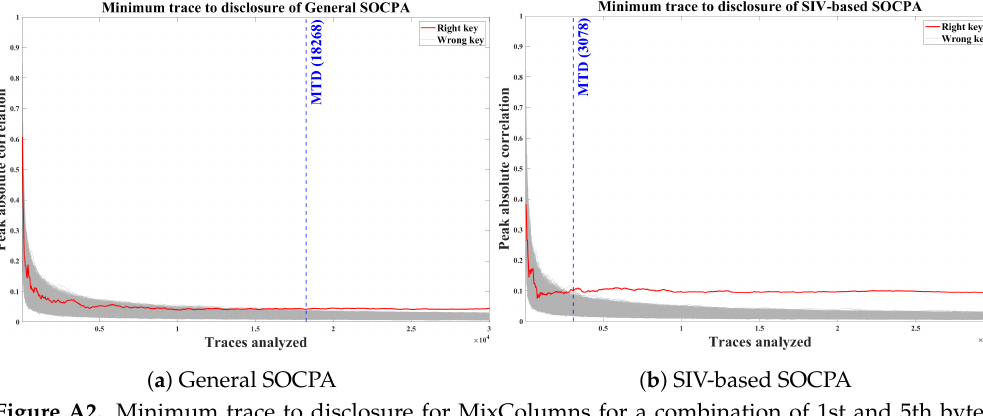
Figure A1. Correlation coefficient of the two versions of SOCPA on MixColumns (Absolute-Difference).